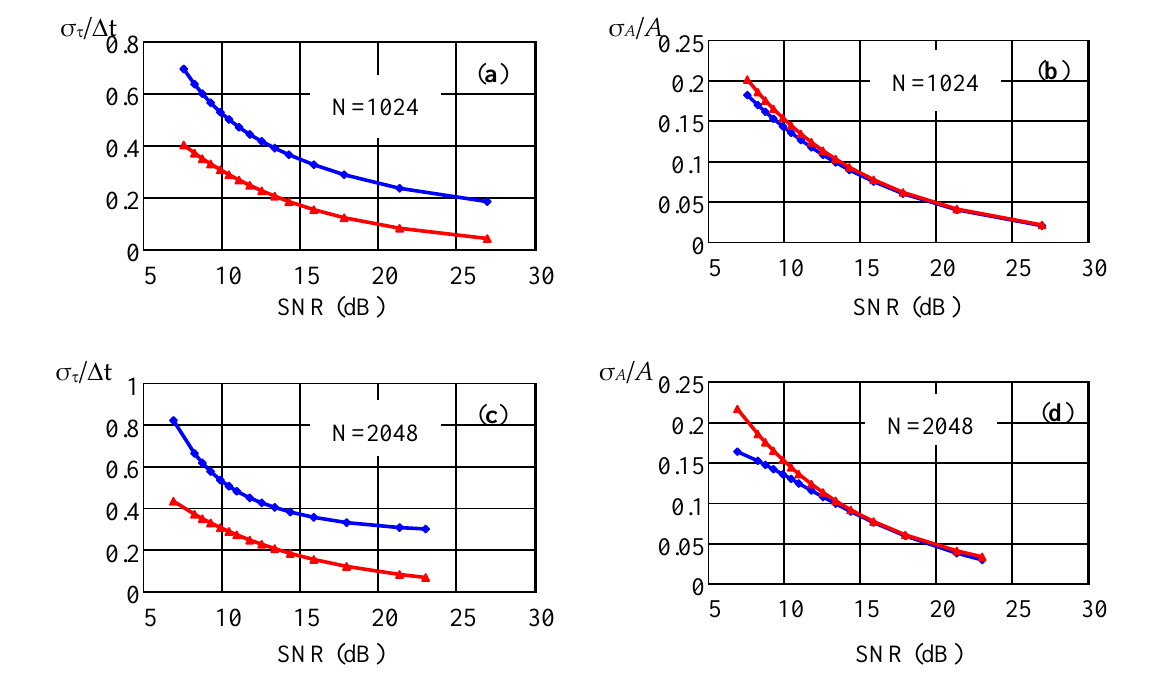
Figure 5. Dependences of the normalized standard deviations of the delay time estimate ( a , c ) and the signal amplitude estimate ( b , d ) on the SNR value for various parameter values N = 1024 and N = 2048, f s = 3 GHz.